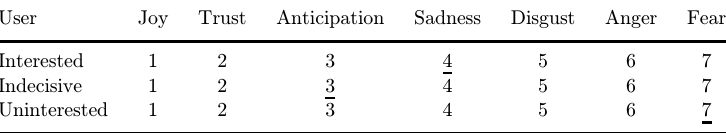
Table 3. Sequence of video sentiment scores according to user classi¯cation.